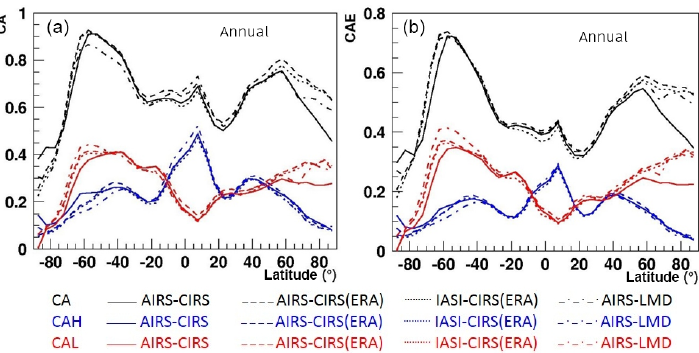
Figure 8. Annual mean zonal distributions of CA, CAH and CAL (a) and CAE, CAEH and CAEL (b) . Results are compared between AIRS-CIRS, using ancillary data from AIRS-NASA and from ERA-Interim, IASI-CIRS and